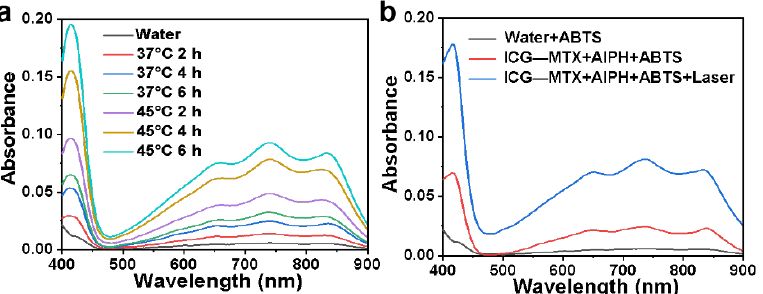
Figure 5. ( a ) The production of ABTS+· induced by free radicals released from AIPH at different temperatures. ( b ) the production of ABTS+· caused by free radicals released from AIPH and ICG — MTX, with/without laser irradiation. MTX, with/without laser